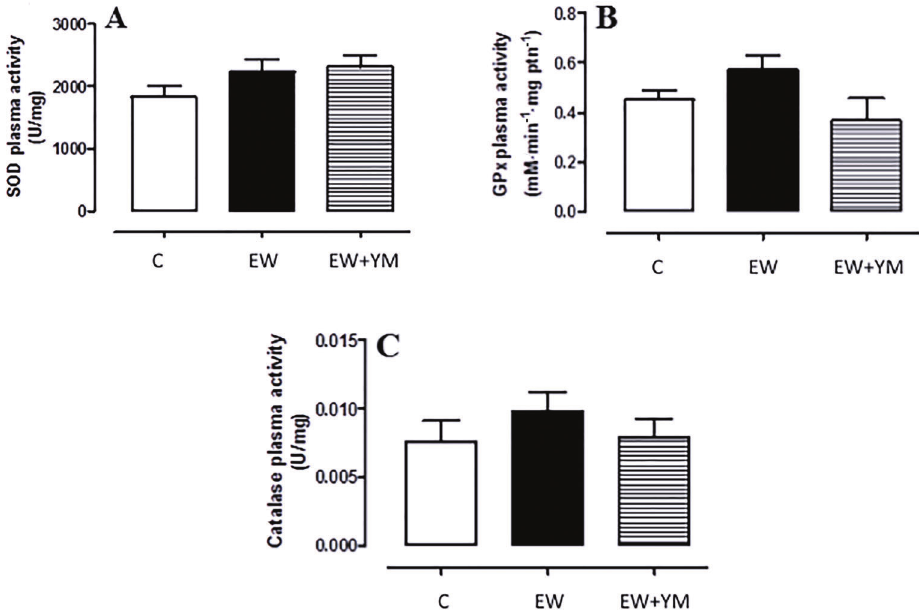
Figure 3. Early weaning and yerba mate treatment did not alter plasma antioxidant enzymes activities. A , superoxide dismutase (SOD), B , glutathione peroxidase (GPx), and C , catalase activities in the plasma at postnatal day 180 of adult rats that were normally breastfed for 21 days (C), early weaned (EW), or EW that received yerba mate for 30 days (EW + YM). Data are reported as means ± SE of 10 rats per group